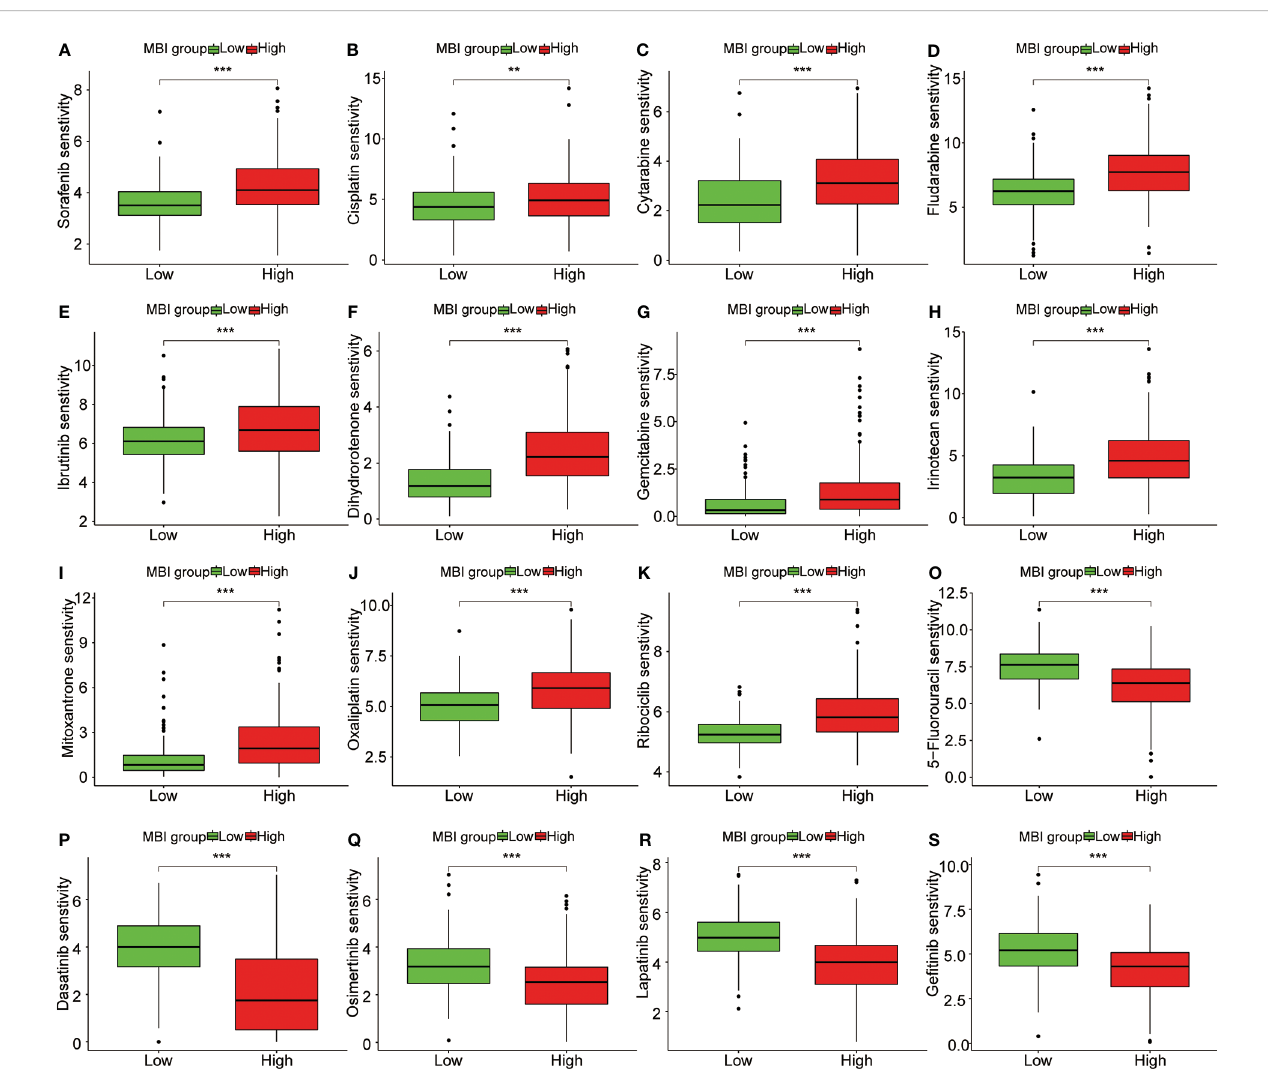
FIGURE 8 Sensitivity analysis of multiple chemotherapeutic agents. (A-K) Sorafenib, Cisplatin, Cytarabine and Fludarabine, Ibrutinib, Dihydrorotenone, Gemcitabine, Irinotecan, Mitoxantrone, Oxaliplatin and Ribociclib had higher IC50 values in the high MBI group. (O-S) 5-Fluorouracil, Dasatinib, Osimertinib, Lapatinib, and Ge fi tinib had higher IC50 values in the low MBI group. ***P < 0.001, **P <